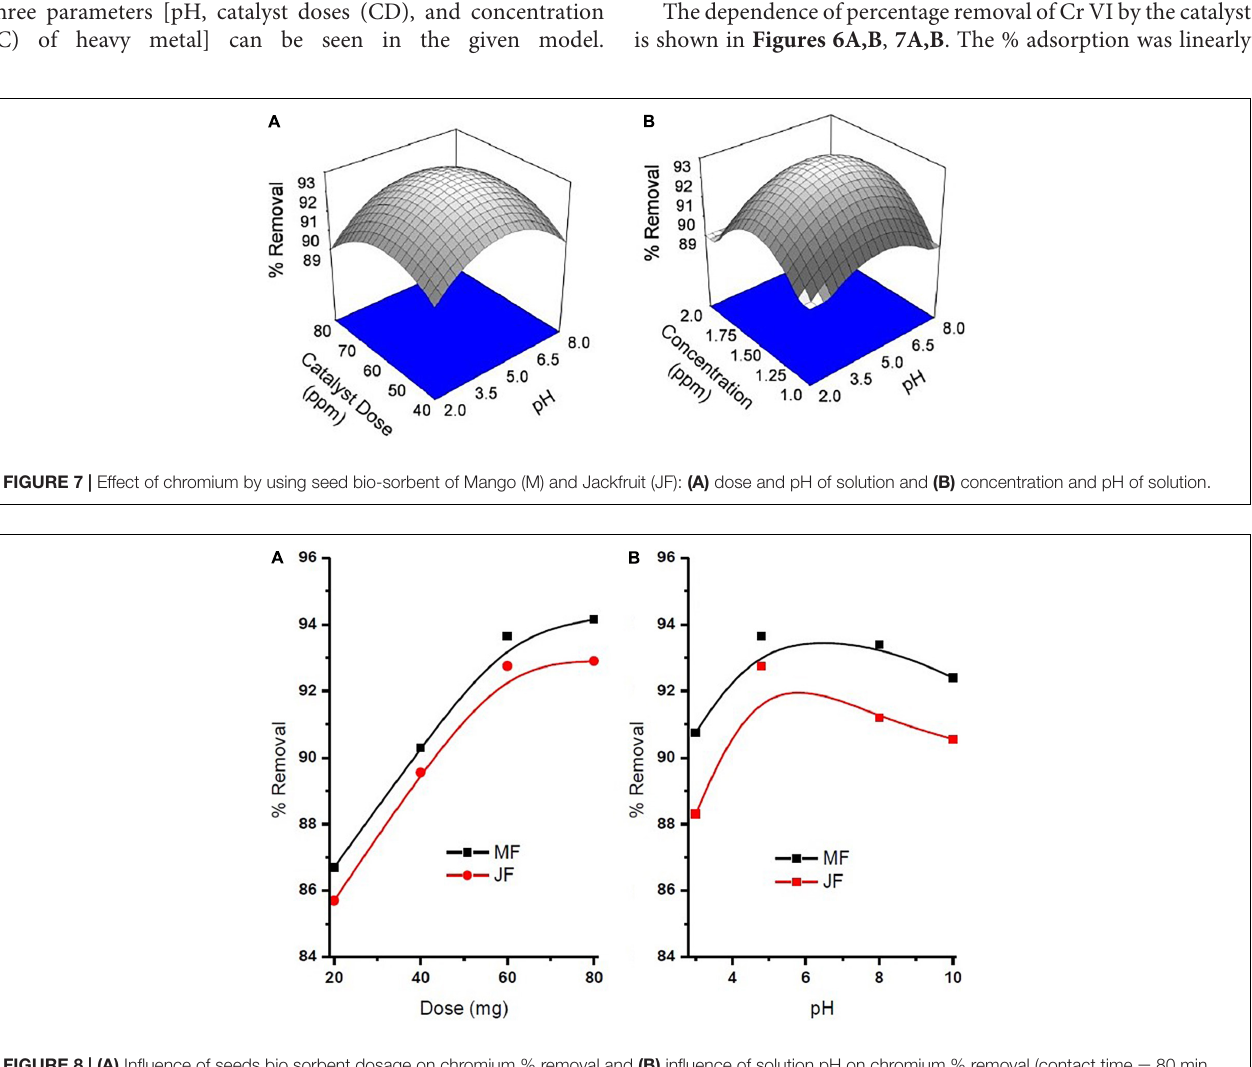
Frontiers in Microbiology |